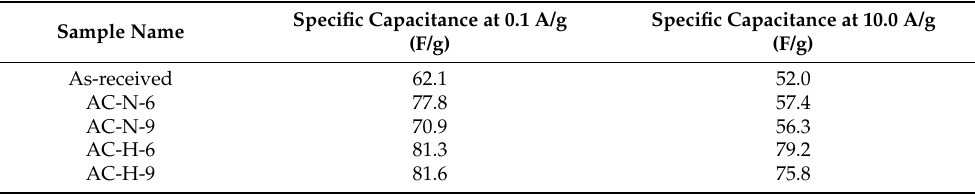
Figure 8. Galvanostatic charge–discharge curves of AC heat ‐ treated under different conditions: ( a ) 0.1 A/g; ( b ) 10.0 A/g.